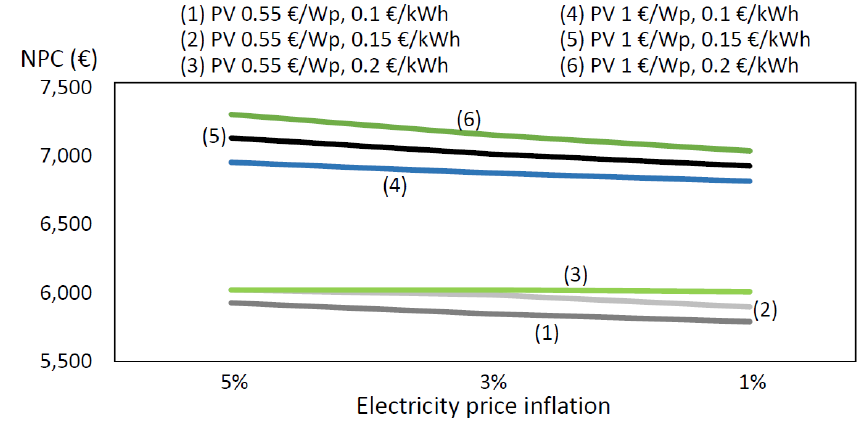
Figure 11. Sensitivity analysis, PV-only systems under net-metering scheme. NPC of the optimal solutions.